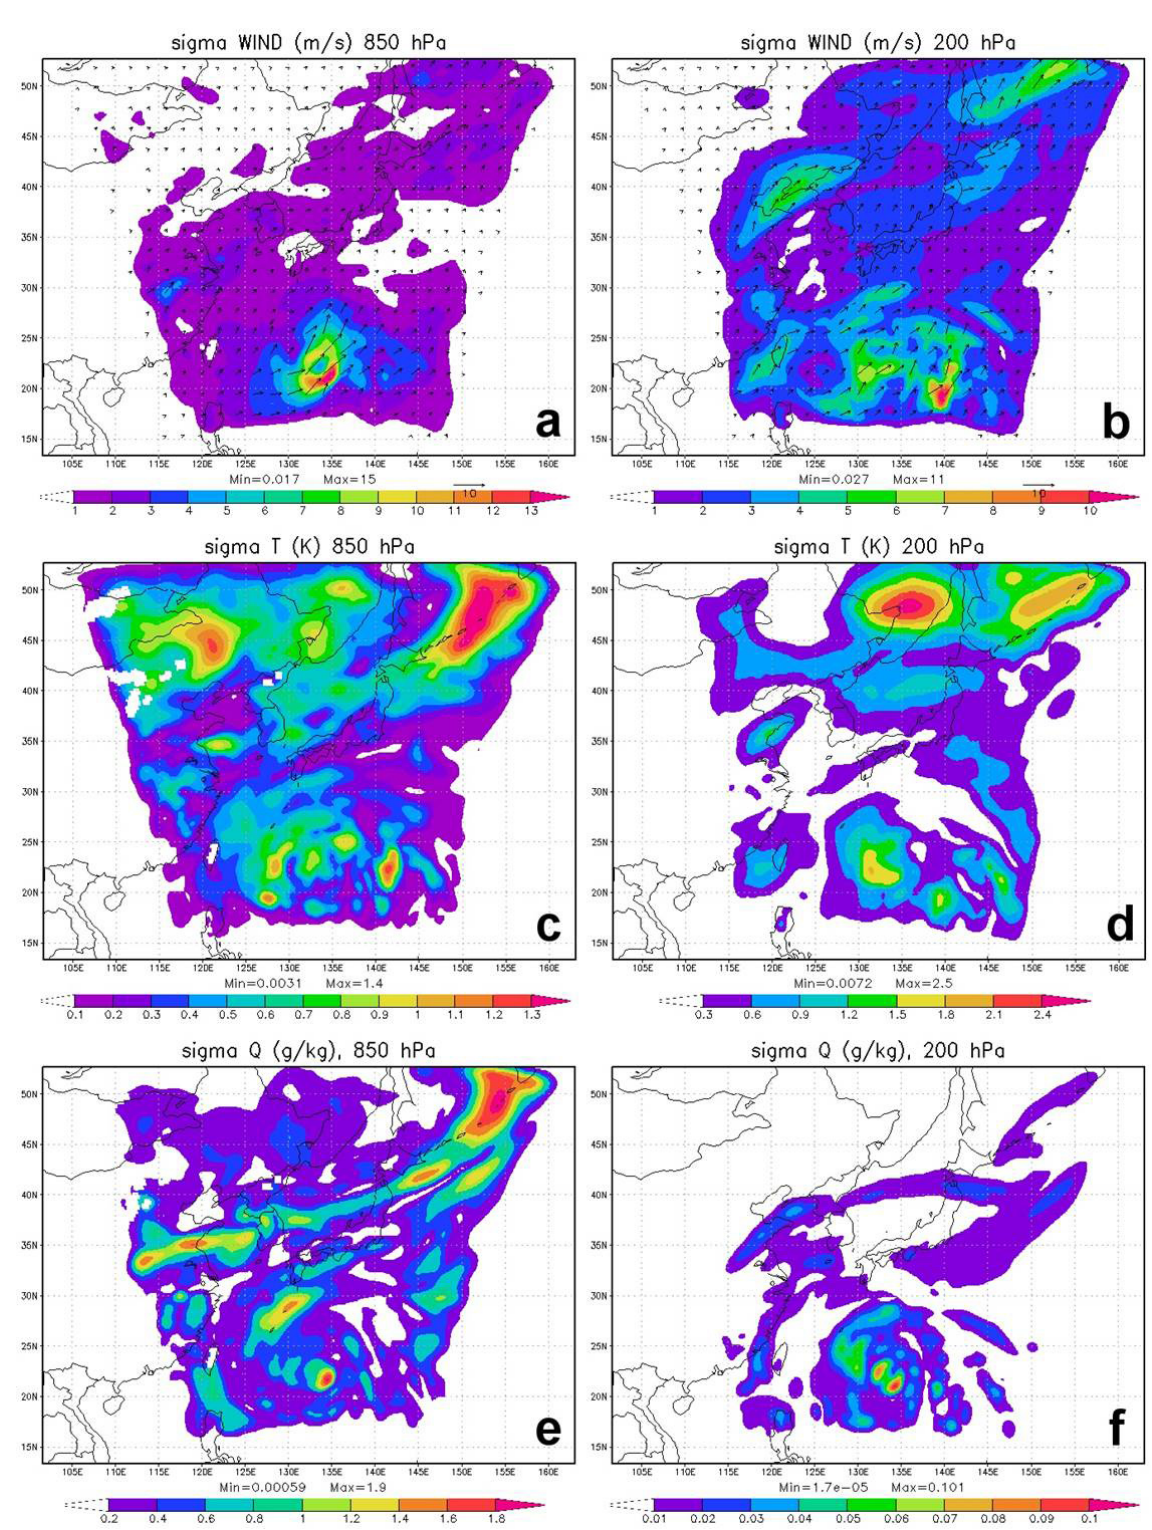
Figure 3. Standard deviation of background error covariance for atmospheric variables valid on 06:00UTC, 3 September 2005 at 850hPa (left panel) for (a) wind, (b) temperature and (c) water vapor mixing ratio, and at 200hPa (right panel) for (d) wind, (e) temperature and (f) water vapor mixing ratio. Units are ms − 1 for wind, K for temperature and gkg − 1 for water vapor mixing